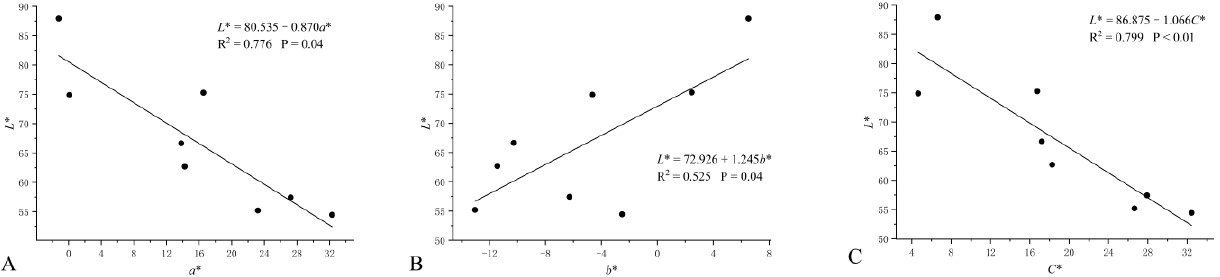
Figure 2. Flower color distribution of Hibiscus syriacus in two-dimensional rectangular ( a *, and b *) ( A ), and three-dimensional ( L *, a * and b *) coordinates ( B ).